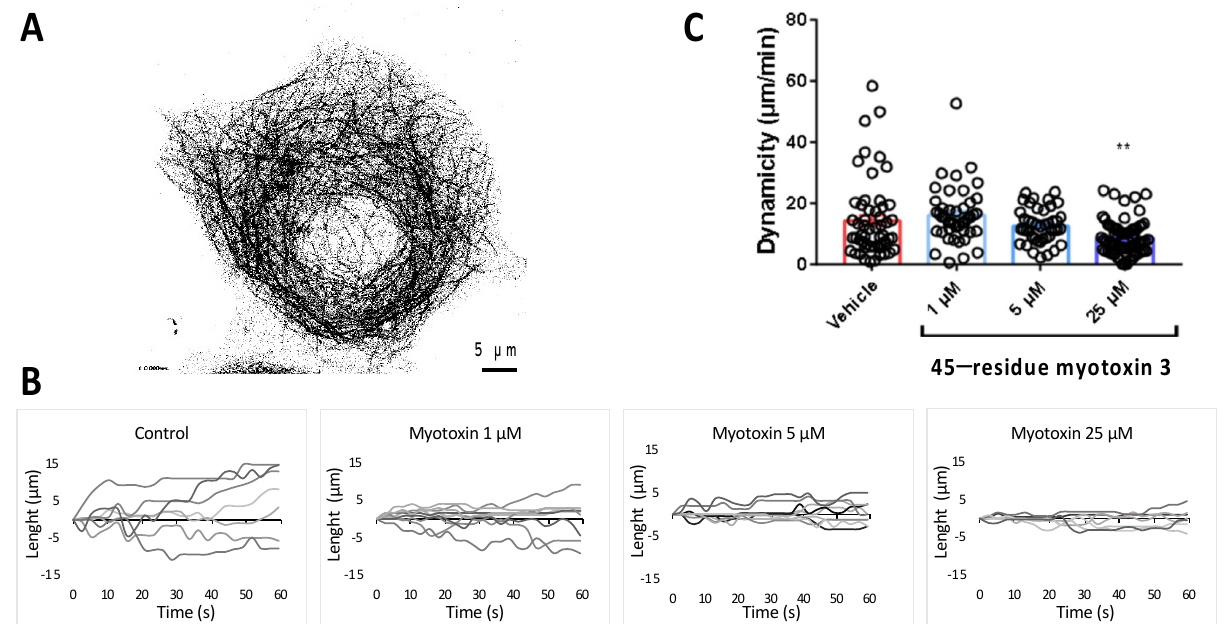
Figure 8. Microtubule dynamics in MCF7 cells treated with myotoxin-3. ( A ) MCF7 cell expressing EGFP-α-tubulin showing labeled microtubules. ( B ) Life history plots of the length changes of 7 microtubules in living MCF7 cells treated or not (control) for 3 h with 45-residue myotoxin 3, as described in the experimental procedure section. In the presence of myotoxin-3, MTs are characterized by less extensive growth and shortening events compared with control cells. ( C ) Overall dynamicity after treatment for 3 h without (control) or with 45-residue myotoxin 3. The data shown are from a representative experiment of two performed. ** p = 0.0013 relative to control.